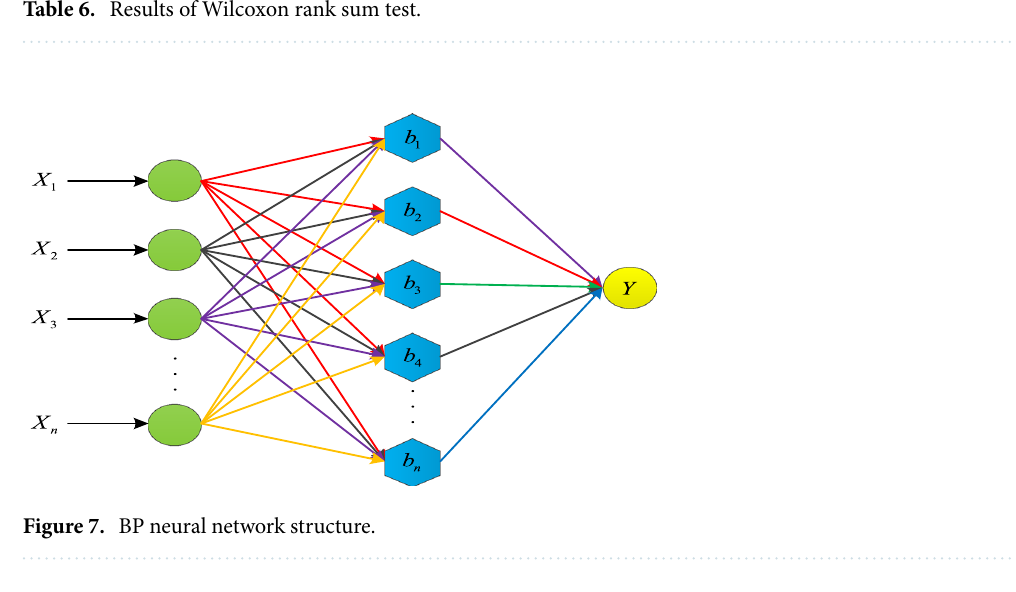
Table 6. Results of Wilcoxon rank sum test.